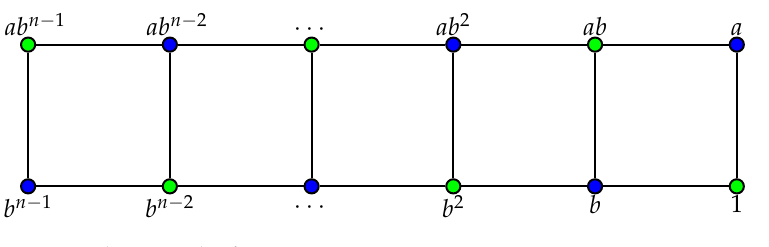
Figure 2. The 1-graph of D n